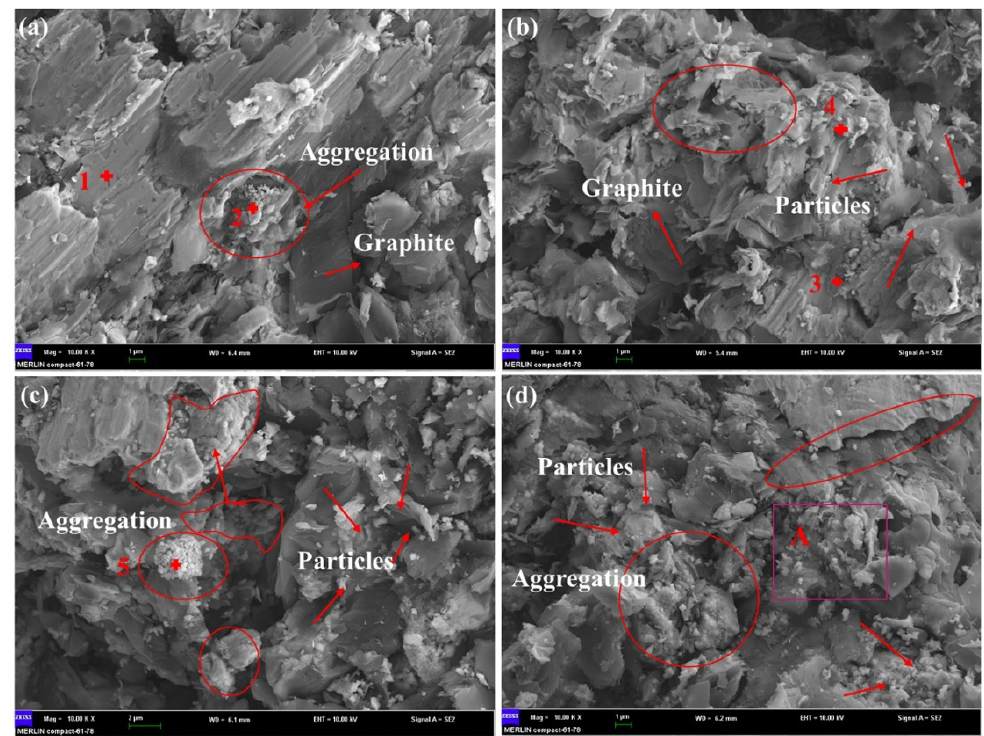
Figure 10. SEM micrographs of fracture surfaces of sintered composites with different content of alumina whiskers: ( a ) 0 wt %; ( b ) 0.5 wt %; ( c ) 1 wt %; ( d ) 1.5 wt %.